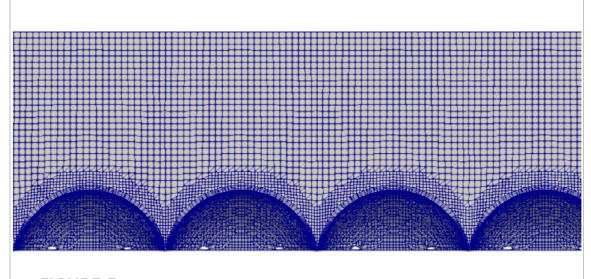
FIGURE 5 Mesh for stage 1 of the simulation, small section of 4 spheres shown.